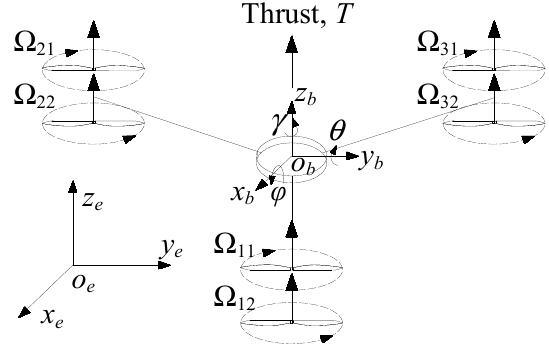
Figure 1. Structure of coaxial Tri-rotor micro air vehicle (MAV).